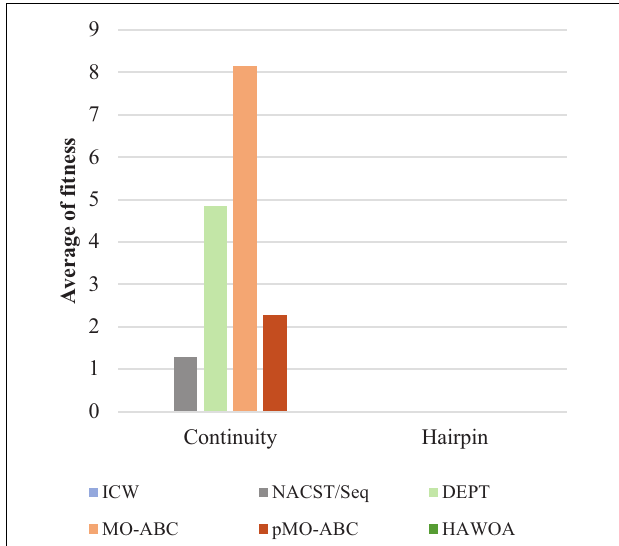
FIGURE 6 | Average fitness of continuity and hairpin for ICW and other algorithms.